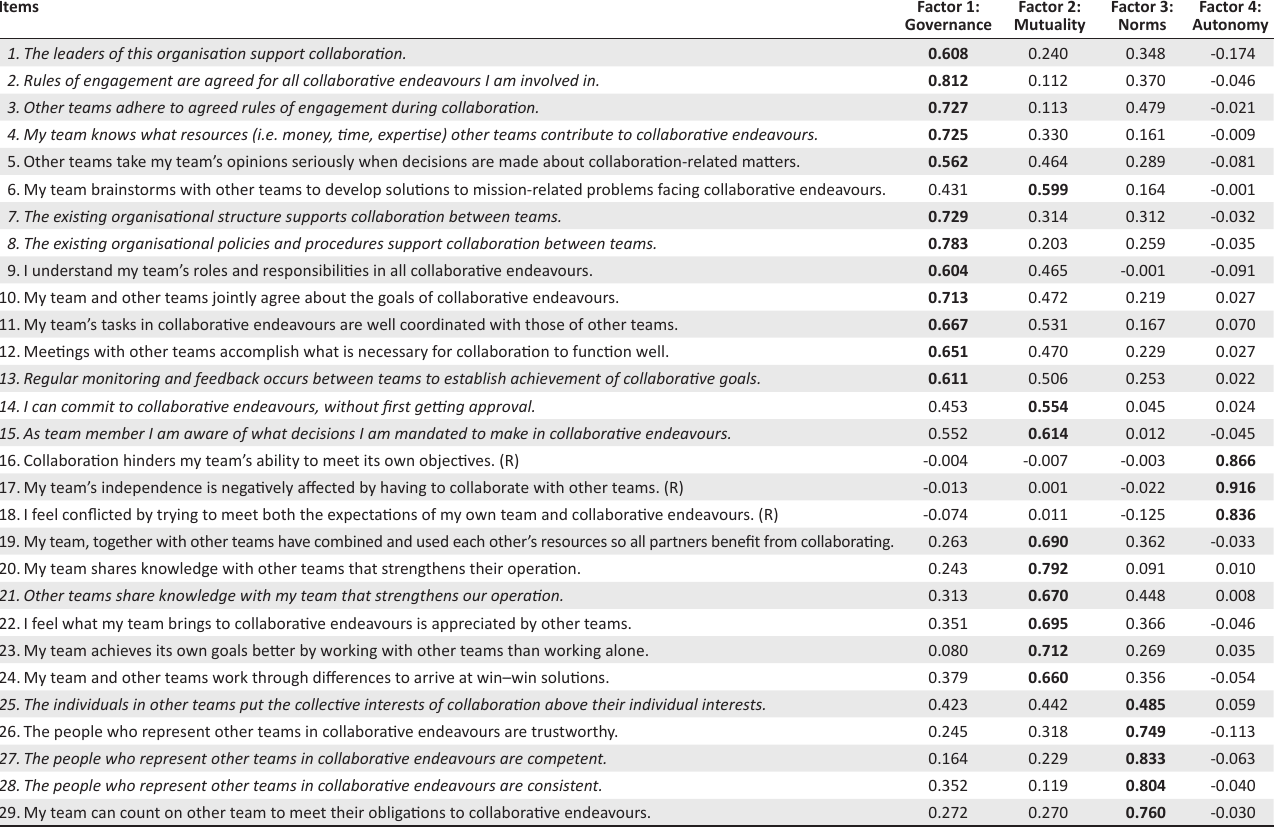
TABLE 2: Principal Components Analysis with Varimax Rotation of the revised Thomson, Perry and Miller (2007) Collaboration Instrument on a four-factor model. Items